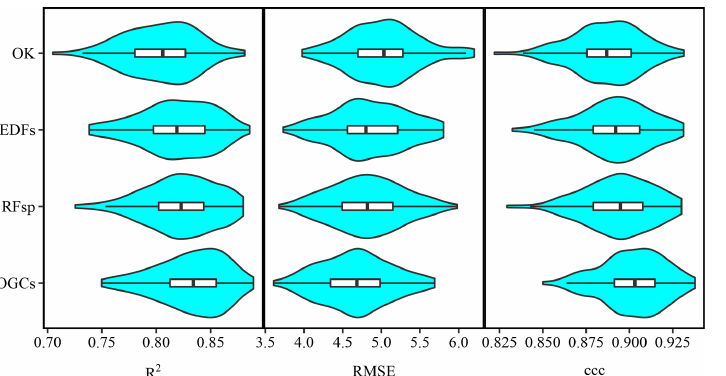
Figure A6. Violin plots showing the accuracies obtained on the Swiss rainfall dataset with each method. The plots show values obtained with 100 splits into training and test